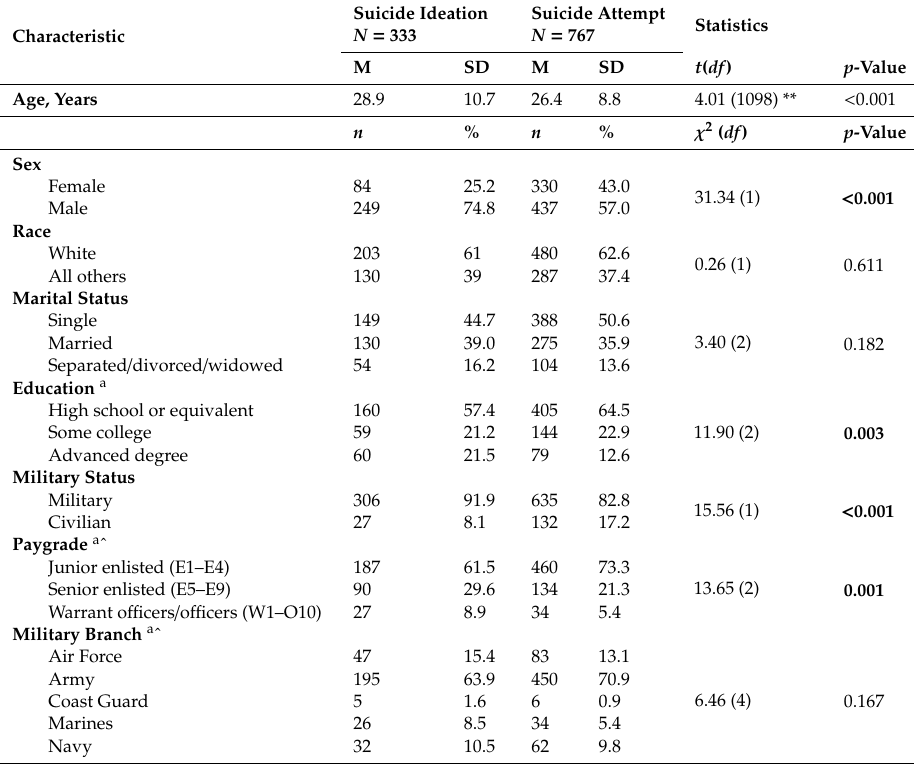
Table 1. Younger age, female gender, lower educational attainment, civilian status, and junior military rank all significantly increased the likelihood that an individual would be hospitalized for SA rather than SI. Table 1. Comparison of demographic characteristics between patients hospitalized for suicide ideation only or following a suicide attempt ( N =